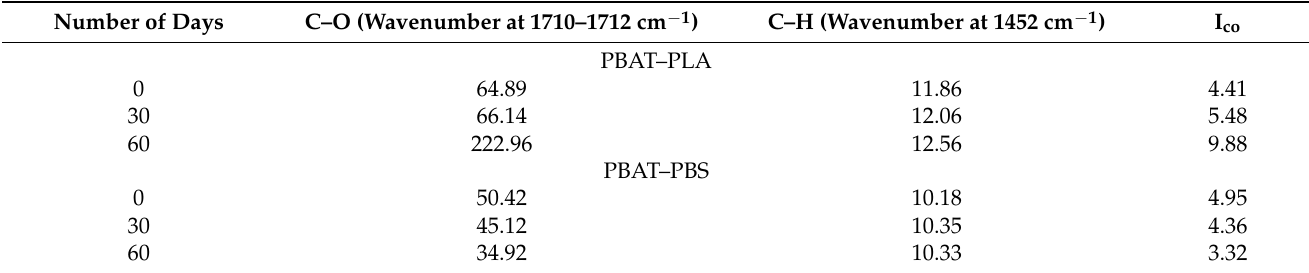
Table 2. Carbonyl index (I co ) for the PBAT–PLA and PBAT–PBS